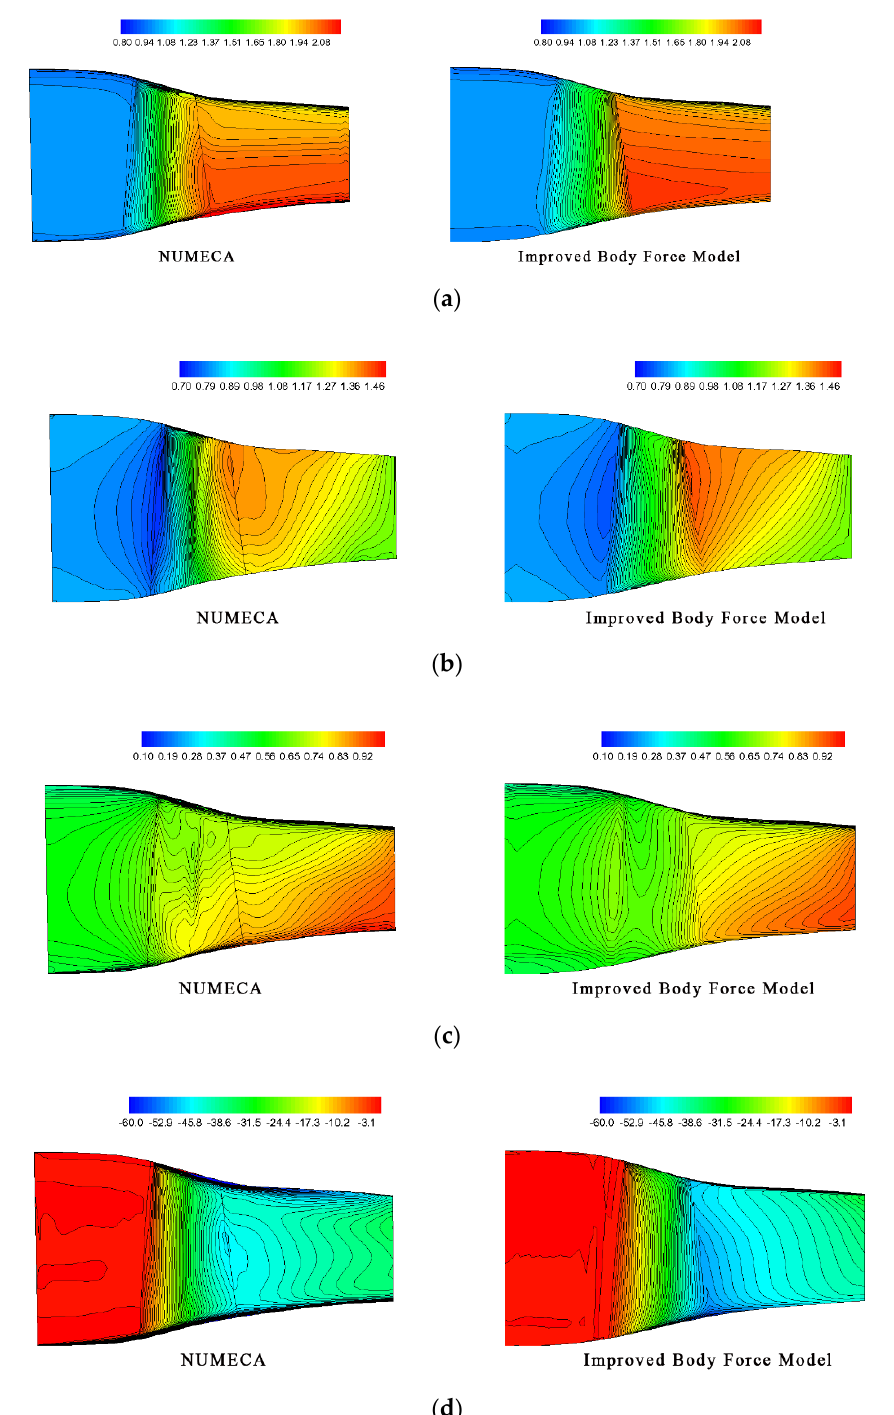
Figure 14. The pitchwise − averaged parameter contours on the meridional plane. ( a ) Dimensionless total pressure contours; ( b ) Dimensionless pressure contours; ( c ) Mach contours; and ( d ) Swirl angle contours.